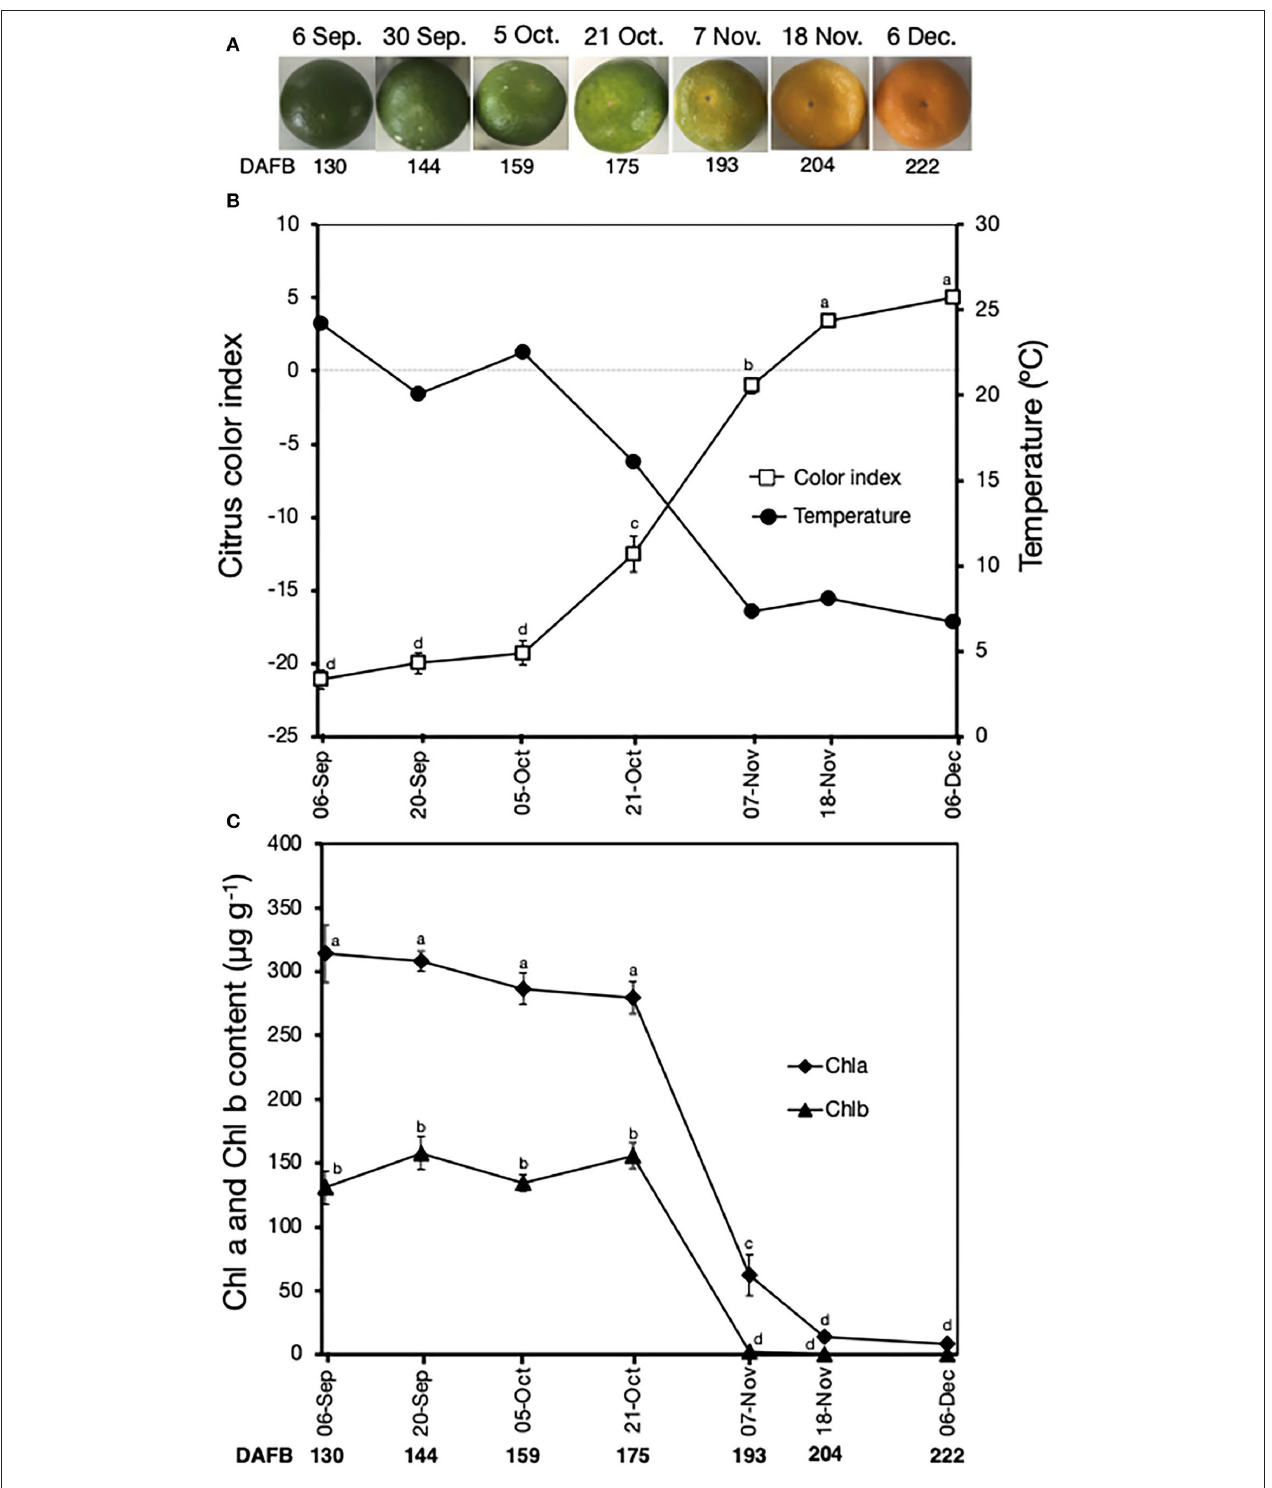
FIGURE 3 | Peel color changes in Satsuma mandarin fruit during on-tree maturation. (A) Appearance of fruit during on-tree maturation. (B) Changes in citrus color index and minimum field temperatures. Data for temperature were accessed from the website of Japan Meteorological Agency (http://www.data.jma.go.jp/obd/stats/ etrn/view/daily_s1.php?prec_no=72&block_no=47891&year=2014&month=12&day=&view=p1). (C) Changes in the peel content of chlorophyll a and chlorophyll b. Data points represent the mean ( ± SE) of five fruit and different letters indicate significant differences in ANOVA (Tukey’s test, P < 0.05). Samples for on-tree assessments were collected in 2017. DAFB, days after full